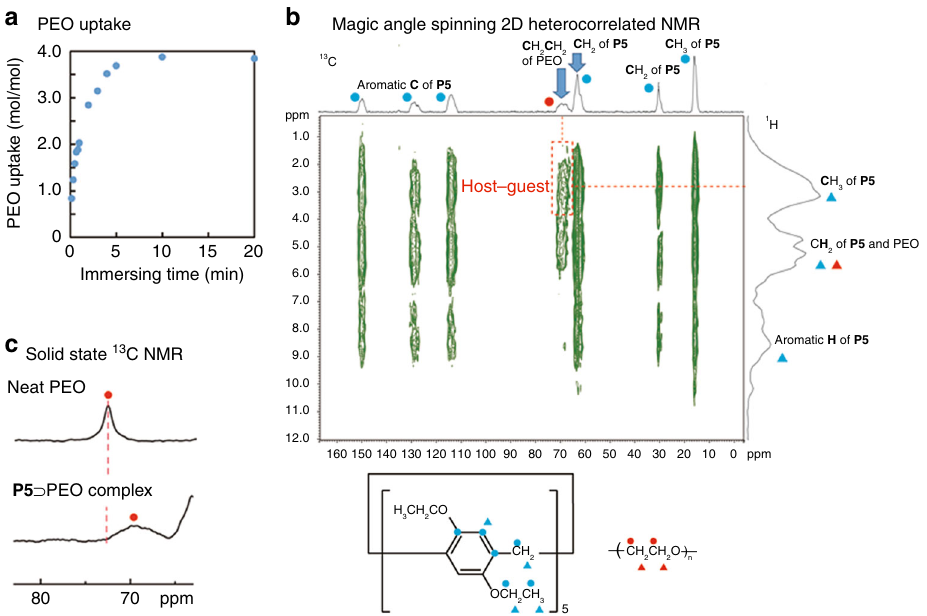
Fig. 2 Encapsulation of polymer in 1D pillar[5]arene channels. a Uptake ratio of poly(ethylene oxide) (PEO1000-OH) by activated crystals of pillar[5]arene P5 (blue circles). b Magic angle spinning 2D heterocorrelated NMR spectrum of P5 ⊃ PEO complex with PMLG homonuclear decoupling (ct = 1 ms). c Solid-state 13 C NMR spectra of neat PEO at 32 °C (top) and the P5 ⊃ PEO complex at 30 °C